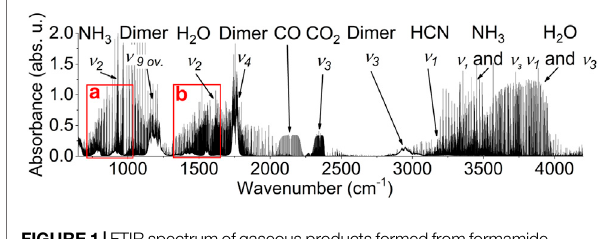
FIGURE1| FTIRspectrumofgaseousproductsformedfromformamide thermolysis at 180 ° C in presence of Fe smectite. Boxes (a) and (b) frame the absorption features of 2-aminoacetonitrile (See Figure 2A ) and formamidine (see Figure 2B ), respectively. Band assignments including those for the non-covalentdimer offormamide areindicated (see Figure3A ); ov .stands for